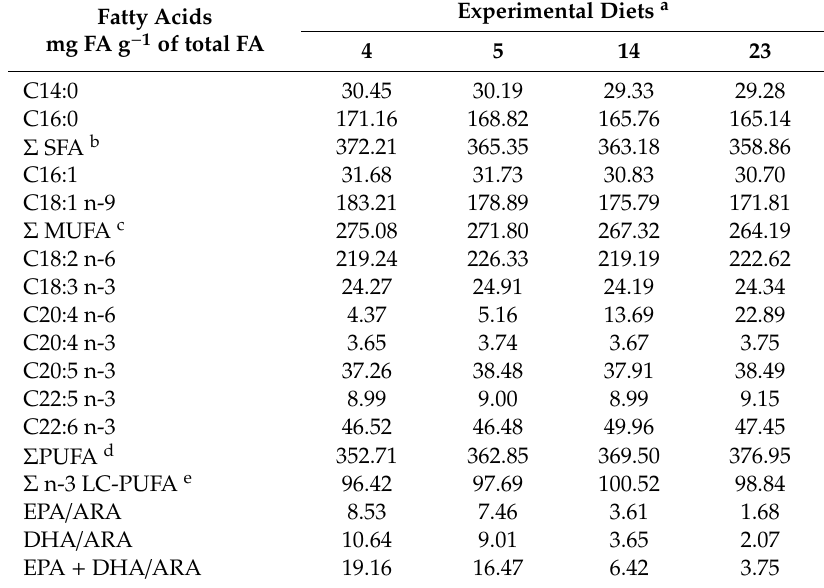
Table 1. Selected fatty acid (FA) composition (mg FA g − 1 of total FA) of experimental diets used for medaka broodstock feeding.The used abbreviations are as follow: SFA (saturated fatty acids); MUFA (monounsaturated fatty acids); PUFA (poly-unsaturated fatty acids ); LC-PUFA (long chain poly-unsaturated fatty acids); EPA (eicosapentaenoic acid); ARA (arachidonic acid); DHA (docosahexaenoic